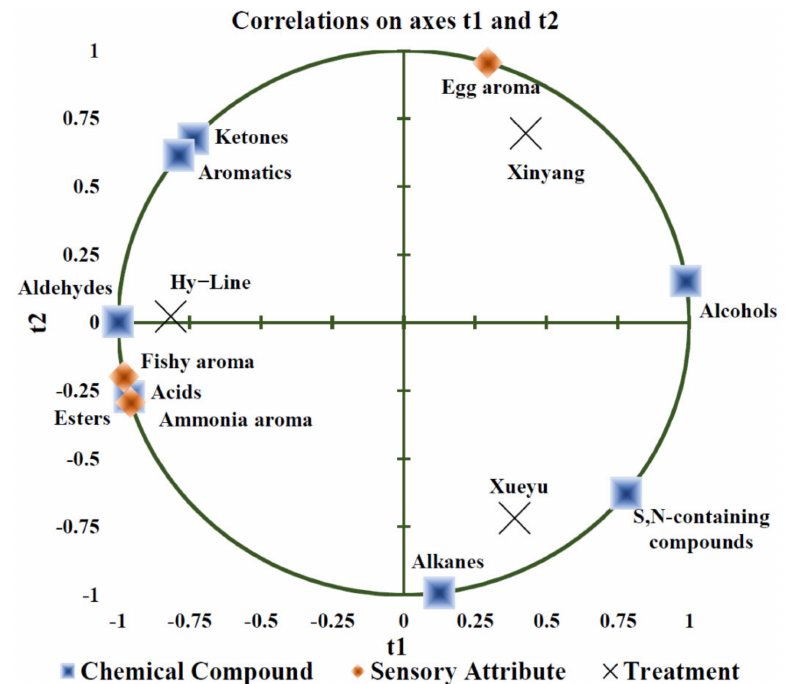
Figure 3. An overview of the correlation loadings from PLS analyses with volatile compounds as X-variables and sensory attributes as Y-variables. Note: Hy-Line: Hy-Line brown; Xueyu: Xueyu White; Xinyang: Xinyang